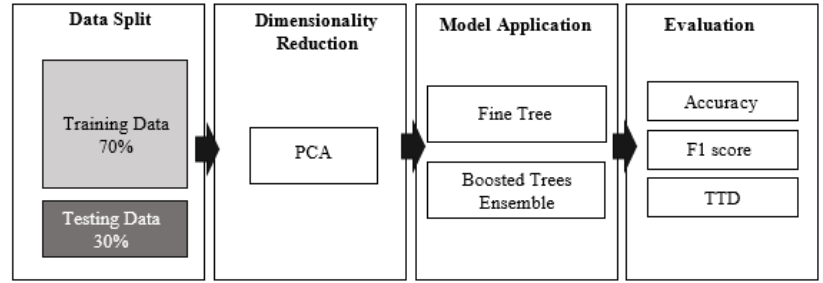
Figure 15. Experiment 3 approach. Table 5. Experiment 3 results.